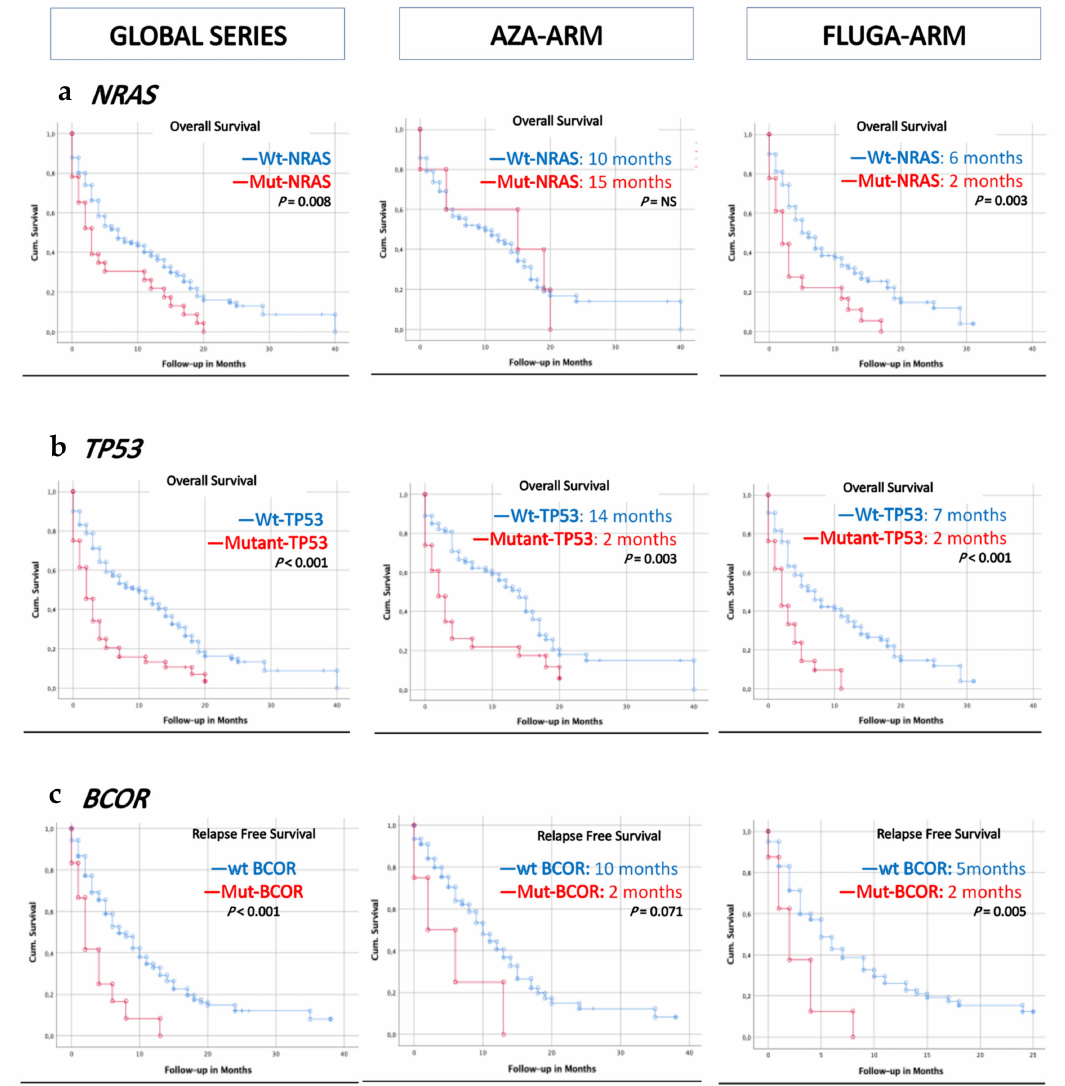
Figure 2. Mutation status has prognostic significance for overall survival and relapse-free survival. In the global series, the AZA arm’s and FLUGA arm’s overall survival and disease free-survival are represented by Kaplan–Meier plots. Wild-type status is indicated in blue and mutated status is indicated in red. NRAS mutations ( a ) and TP53 mutations ( b ) are adverse factors affecting overall survival in the FLUGA arm. BCOR mutations are adverse factors affecting relapse-free survival in the AZA and FLUGA arms ( c ). AZA: azacytidine, FLUGA: fludarabine plus low-dose cytarabine